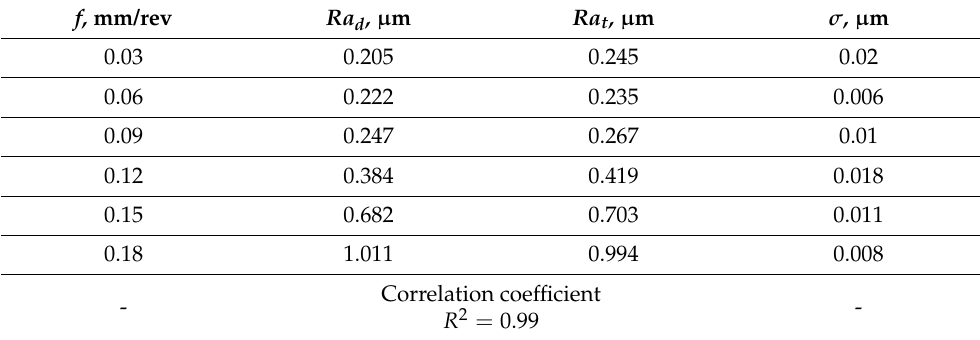
Table 5. Comparison of the roughness parameter prediction model with actual surface